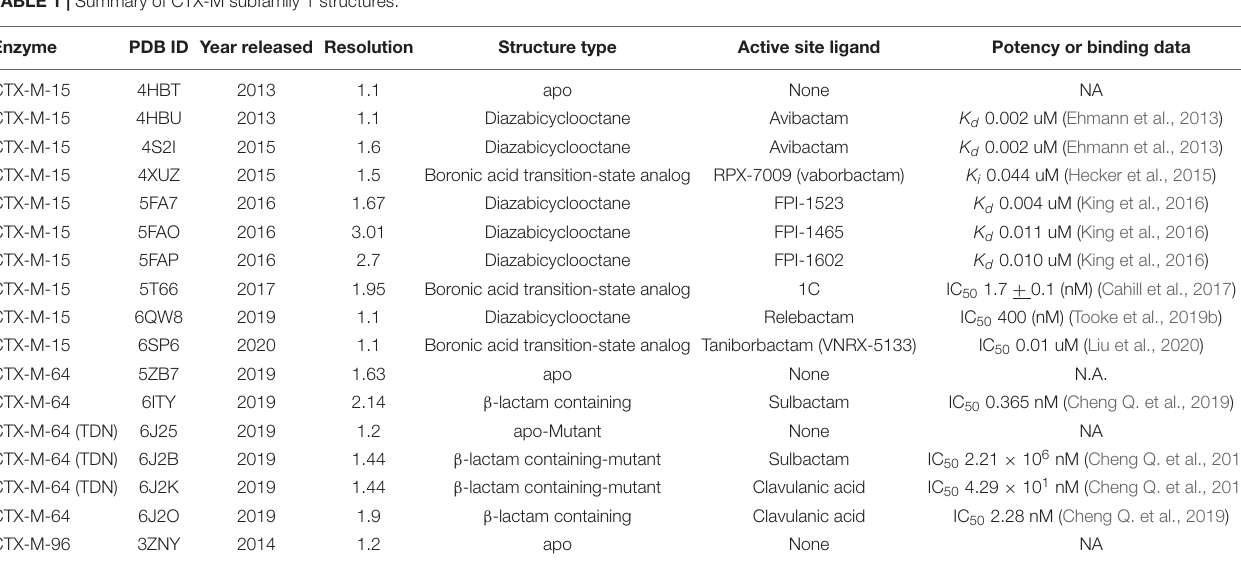
TABLE 1 | Summary of CTX-M subfamily 1